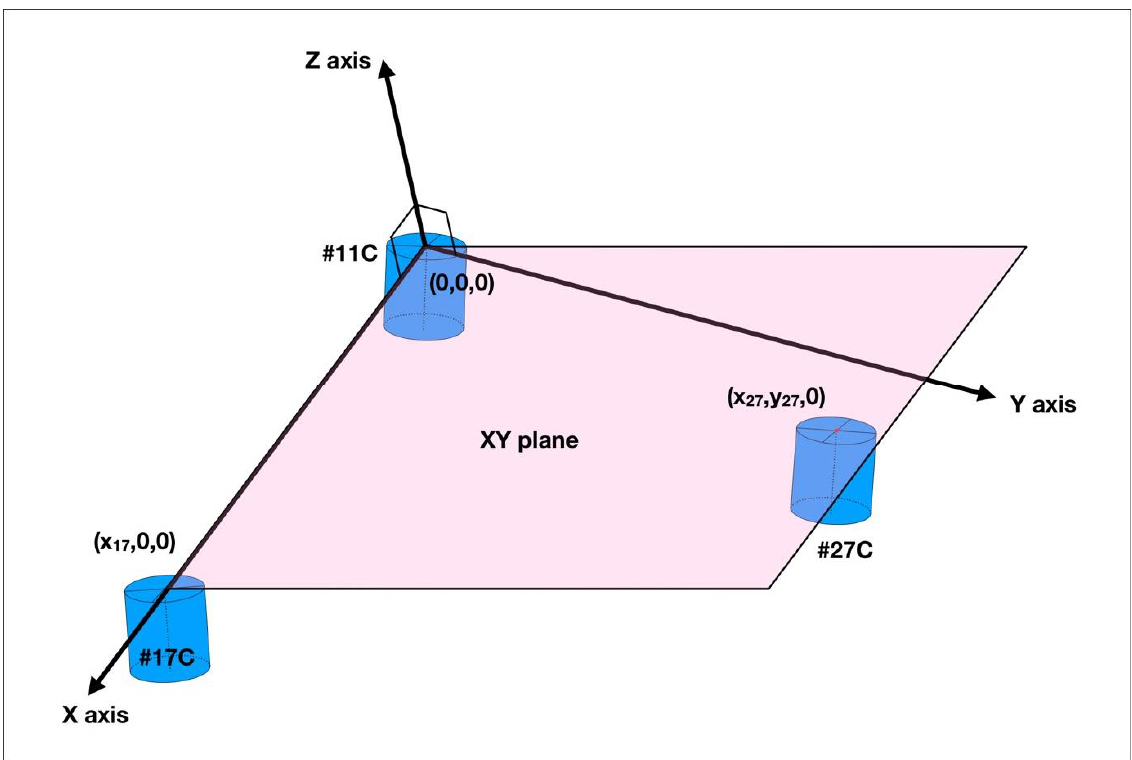
Figure 6. The part coordinate system used in the current study. Centroid of #11C was defined as the origin (0, 0, 0). The line connecting the centroids of #11C and #17C was designated as the X -axis. A plane consisting of three points, the centroids of #17C, #11C, and #27C, was designated as the XY plane.